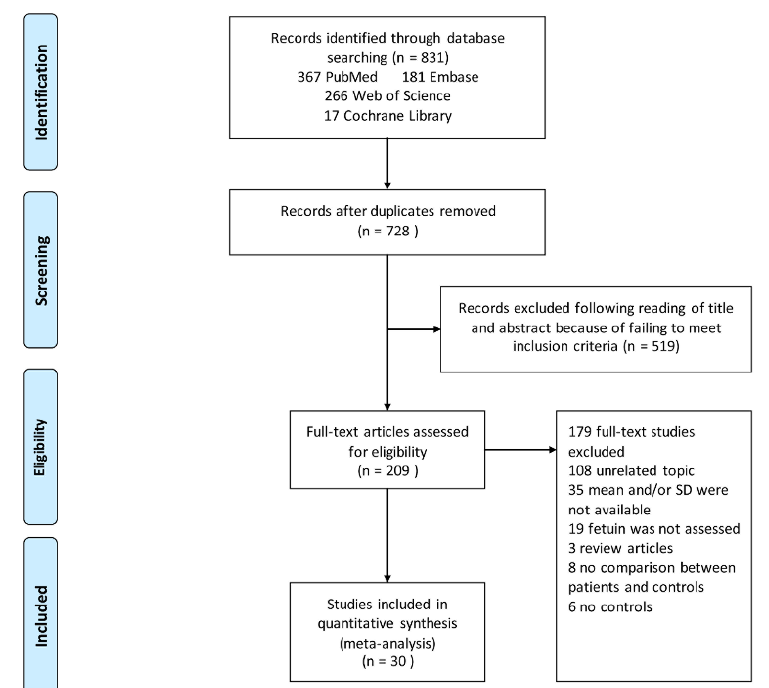
Figure 1. Flowchart of study selection. Showing the process by which retrieved studies from the databases were assessed and selected or excluded. Preferred reporting items for systematic reviews and meta-analyses (PRISMA) diagram for study search.